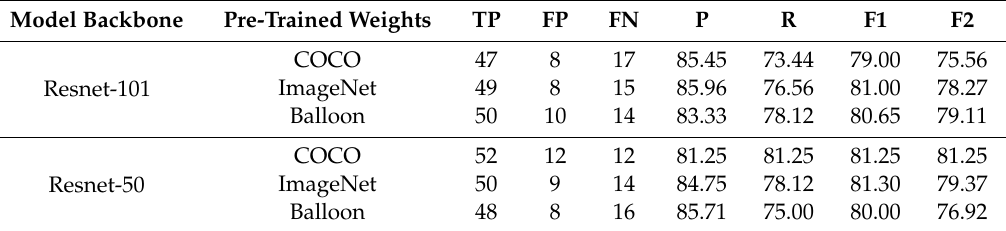
Table 3. Results from testing on CVC-PolypHD polyp